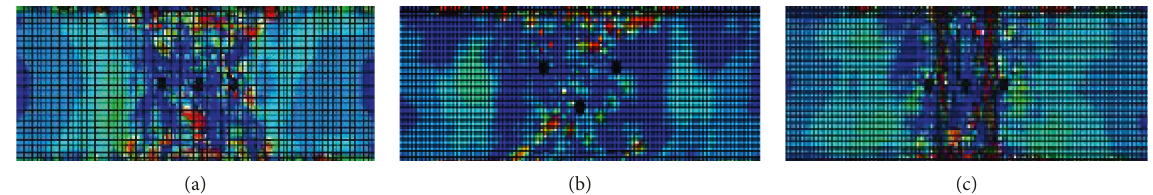
Figure 14: Mises stress nephogram of roof section in the next 0.3ms after blasting. (a) “Straight-line” blasting layout. (b) “Triangle-fractal” blasting layout. (c) “Deep-shallow-fractal” blasting layout.